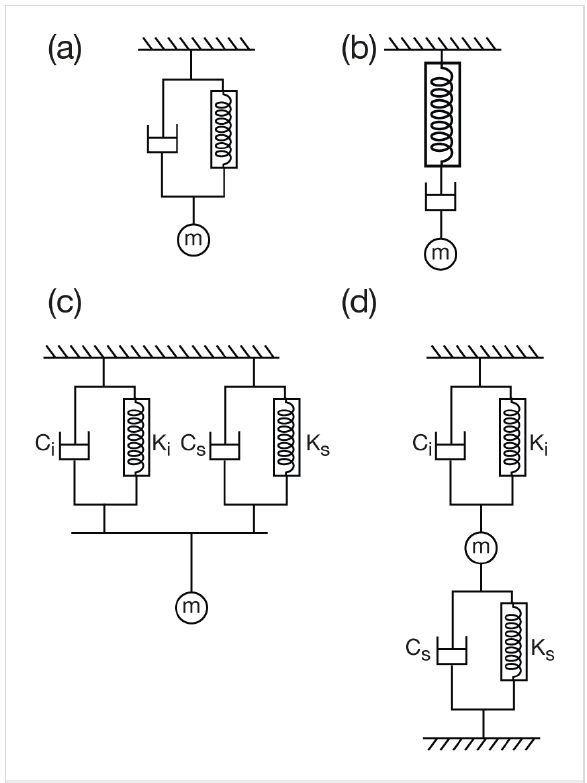
Figure 4: Fundamental models for a viscoelastic mechanical system. (a) Voigt model (b) Maxwell model (c) Generalized Voigt model with 2 components (d) Voigt–Kelvin